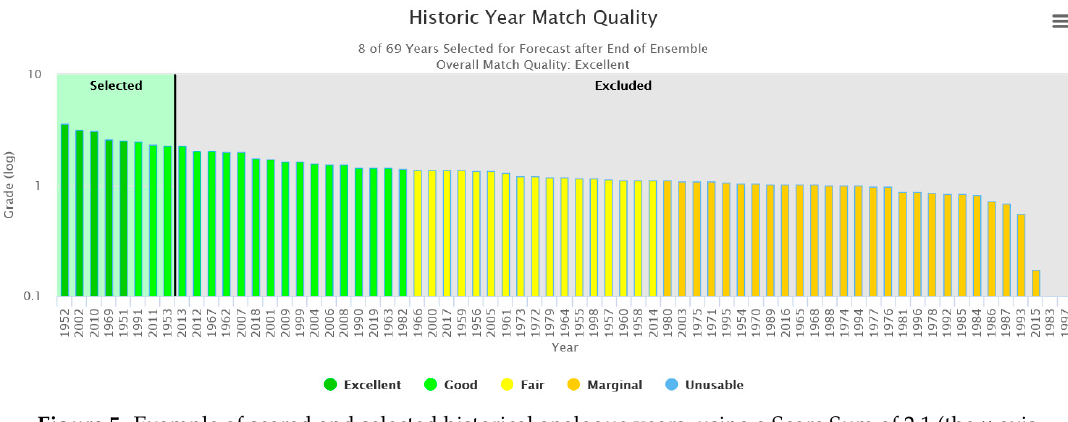
Figure 5. Example of scored and selected historical analogue years, using a Score Sum of 2.1 (the y -axis is an intermediate variable related to the match score and is on a log scale). Years are classified by their match quality as being excellent, good, fair, poor, or unusable as selected historical analogue years.